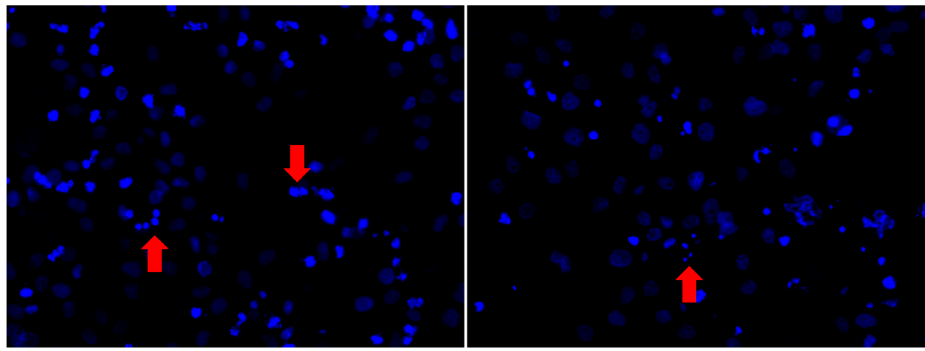
Figure 4. T47-D cells stained with Hoechst 3342, after treatment with 3g during 72 h. Pycnotic cells with circular morphology are indicative of apoptosis.